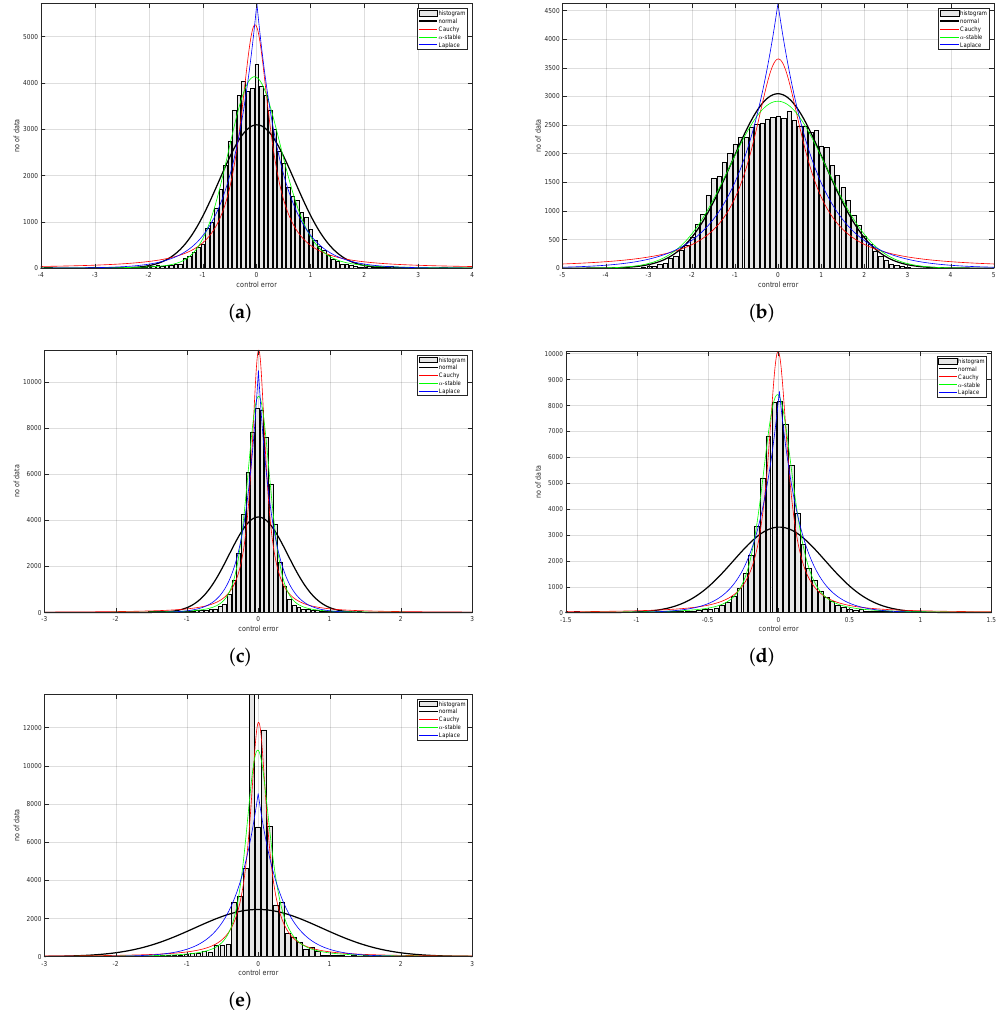
Figure 9. Histograms for time series of the industrial data with PDF fitting. ( a ) Control error u ( k ) , ( b ) Control error w ( k ) , ( c ) Control error x ( k ) , ( d ) Control error y ( k ) , ( e ) Control error z ( k )